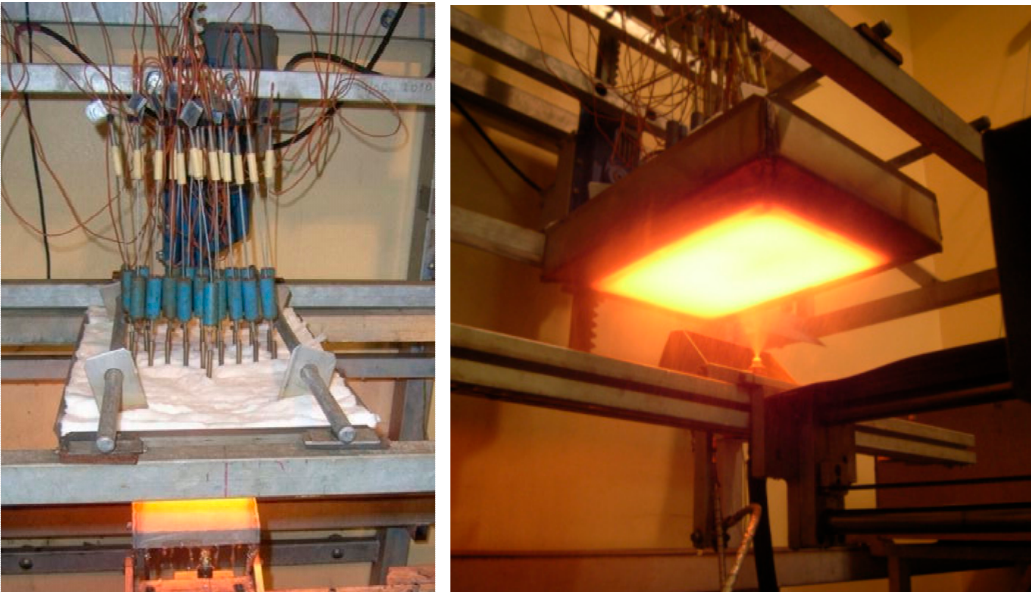
Figure 3. Test bench for HTC tests, insulated upper surface of test plate with thermocouples ( left ), nozzle on moving trolley spraying test plate, deflector is open ( right ).